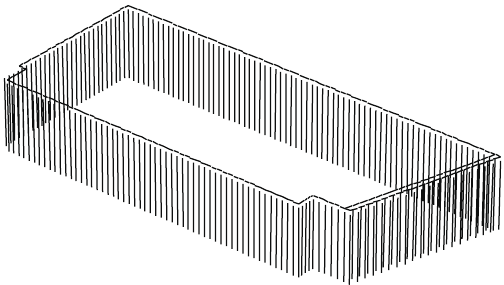
Figure 6: Support pile and top beam structure model.